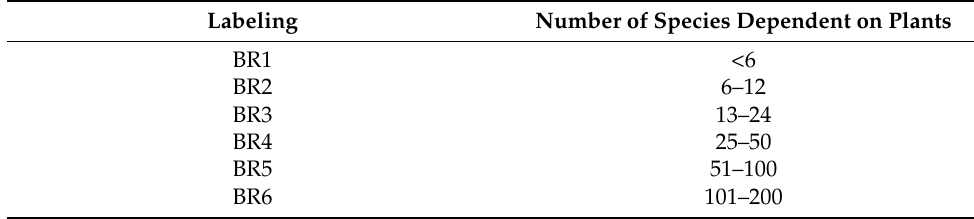
Table 2. Biological relevance of found weed